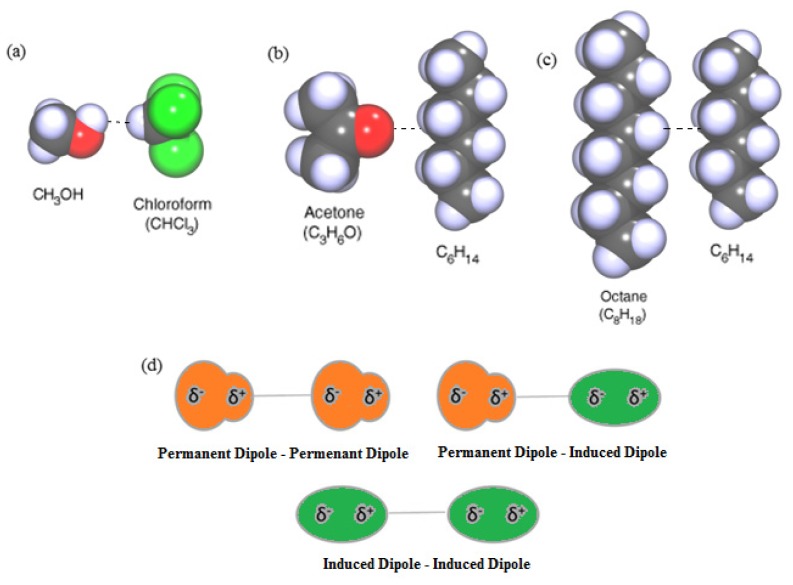
(a) Permanent Dipole-Permanent Dipole or Keesom forces. They exist only between polar molecules, being stronger than London forces for molecules of equivalent size; (b) Permanent Dipole-Induced Dipole or Debye force. It arises from the distortion of the charge cloud induced by a polar molecule nearby, i.e., a non-polar molecule will be temporarily polarized in the vicinity of a polar molecule, and the induced and permanent dipoles will be mutually attracted; (c) Instantaneous Dipole-Induced Dipole or London forces. They result from electrostatic attraction between temporary dipoles and induced dipoles caused by movement of electrons; these are attraction forces that operate between all molecules and among isolated atoms in noble gases. The strength of the forces is related to the number of electrons present and hence to the size of the molecule (or isolated atom); (d) Interactions between molecules–temporary and permanent dipoles.